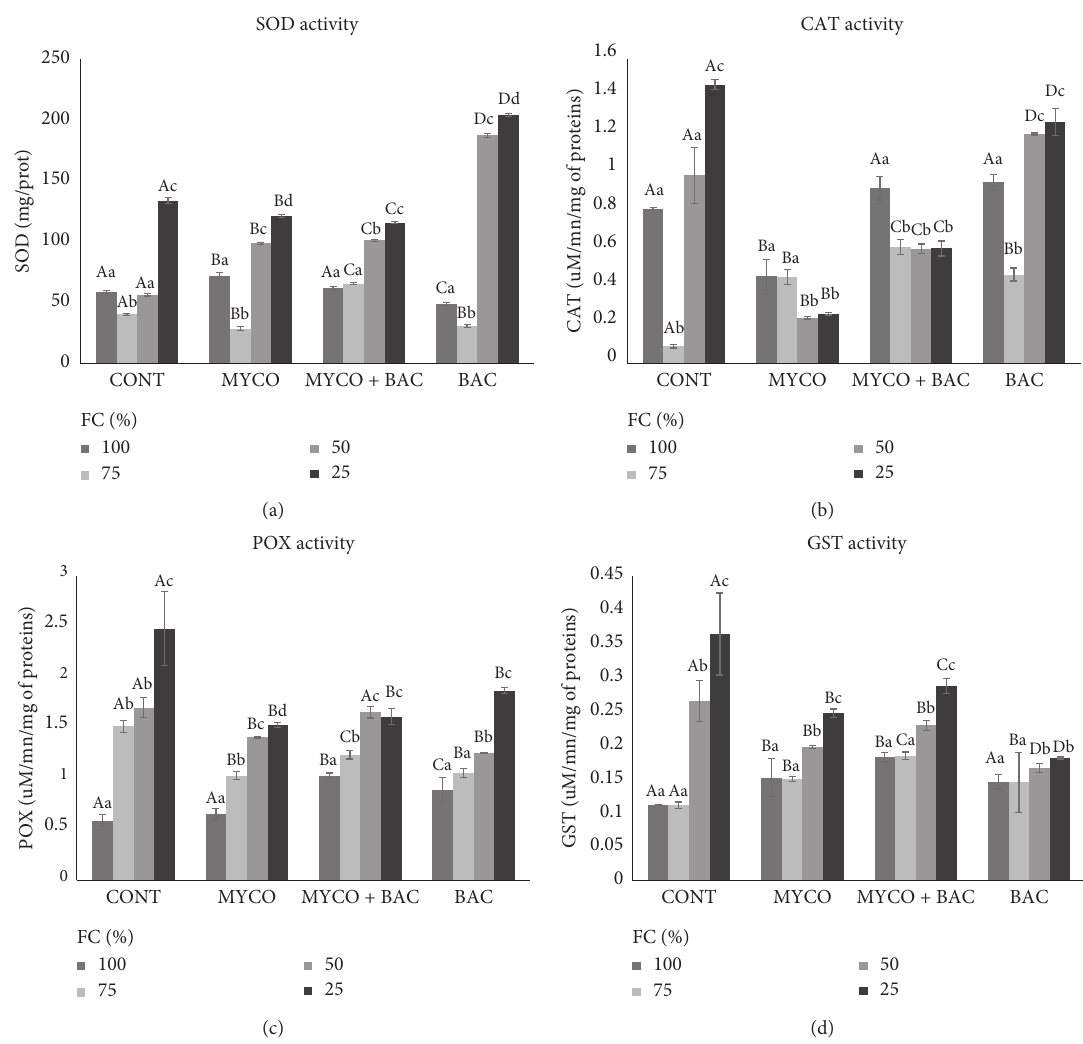
Figure 5: Enzyme activities of (a) superoxide dismutase (SOD; units.mg.protein.min − 1 ), (b) catalase (CAT; µ M.mg − 1 .protein.min − 1 ), (c) peroxidase (POX; µ M.mg − 1 .protein.min − 1 ), and (d) glutathione S-transferase (GST; µ M.mg − 1 .protein.min − 1 ) in leaves of date palm seedlings (CONT: control; MYCO: mycorrhizae; MYCO +BAC: mycorrhizae +bacteria; BAC: bacteria) subjected to different field capacity (FC). Vertical bars represent the standard deviation ( n � 3). Bars with different lowercase letters indicate significant differences between FC at the same treatments ( p < 0 . 05). Bars with different uppercase letters indicate significant differences between treatments at the same FC ( p < 0 .